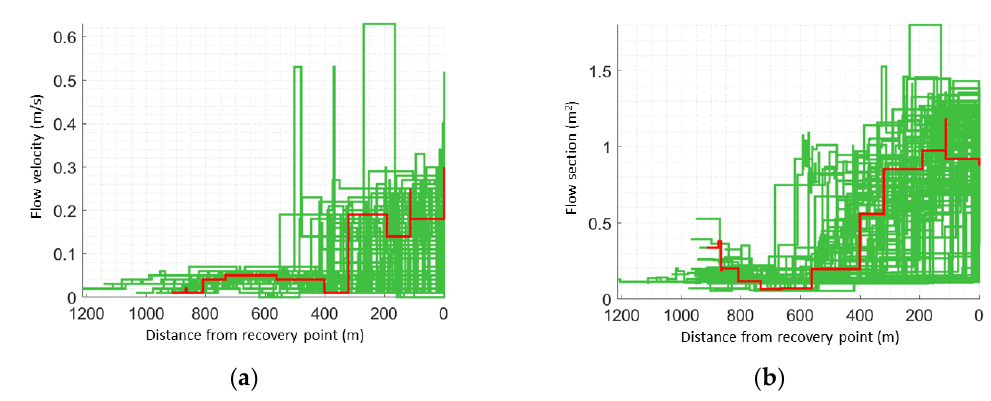
Figure 8. ( a ) Flow velocity along with the tracer transport and ( b ) flow section along with the tracer transport. Green lines correspond to simulations providing an NSE superior to 0.8 and red lines correspond to simulation providing the best NSE (0.89).